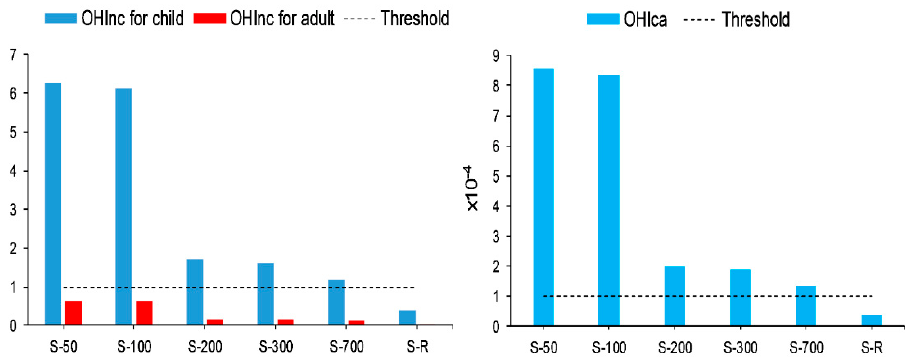
Figure 5. Overall hazard index (OHI) of HMs in the soil located at different distances from the Alaverdi copper smelter.